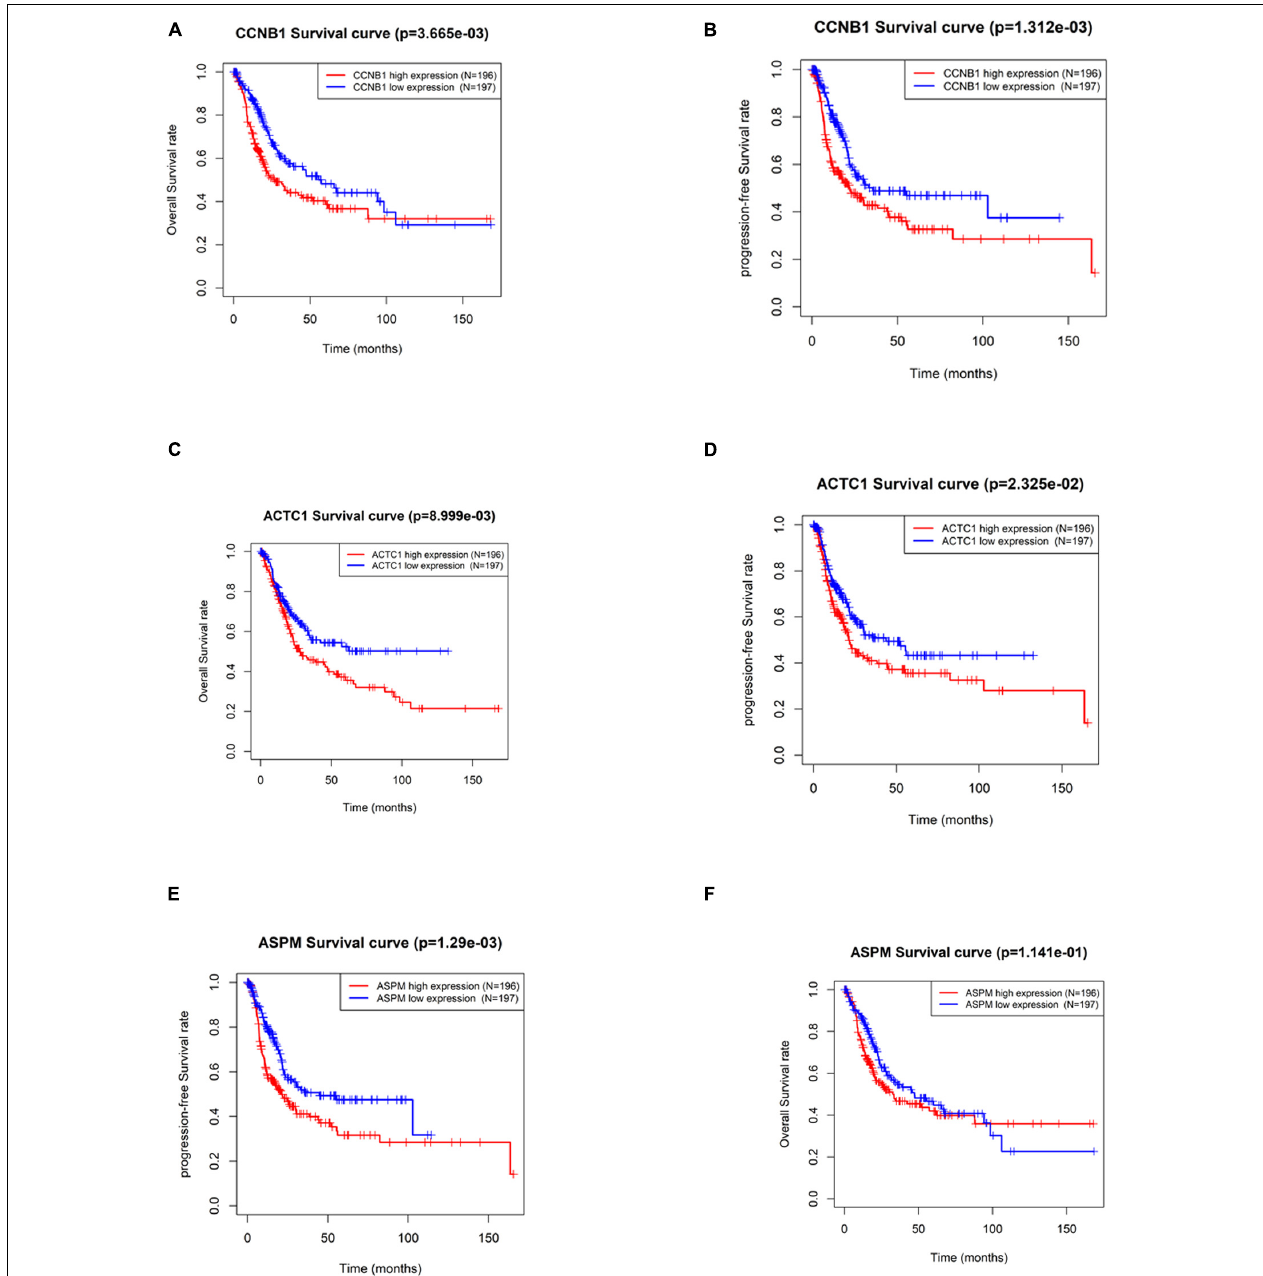
FIGURE 4 | Significance of hub genes in the prognosis of patients with bladder transitional cell carcinoma (BTCC). (A,B) Overall survival (OS) and progression-free survival (PFS) analysis of patients based on high and low expression of CCNB1, respectively. (C,D) OS and PFS analysis of patients based on high and low expression of ACTC1, respectively. (E,F) OS and PFS analysis of patients based on high and low expression of ASPM, respectively. The red line represents high-expression group, and the blue line represents low-expression